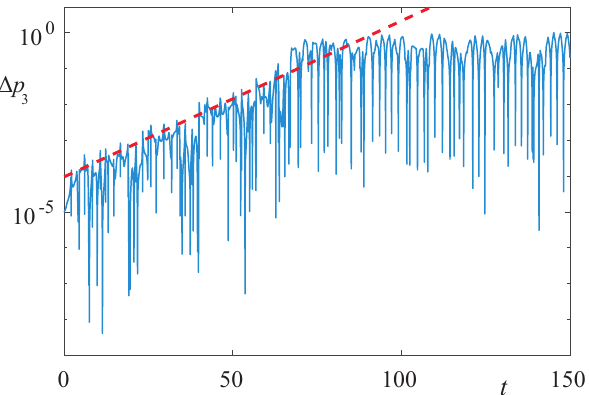
Figure 3. The difference between two initially close positions of third pole is shown versus time, the red dashed line corresponds to the exponential fit: 10 − 4 exp ( 0.1 t )